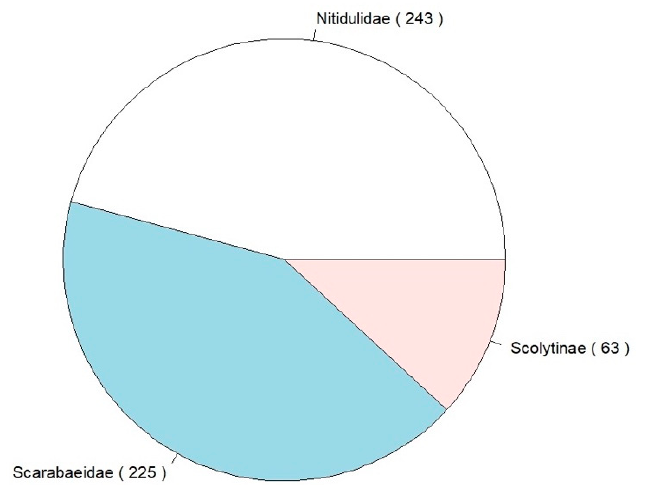
Figure 2. Beetle families collected during the survey; total number of individuals given in brackets. Table 3. Coleoptera species collected during the survey. ( V —Vinegar; W —wine; E —Alcohol.) Species